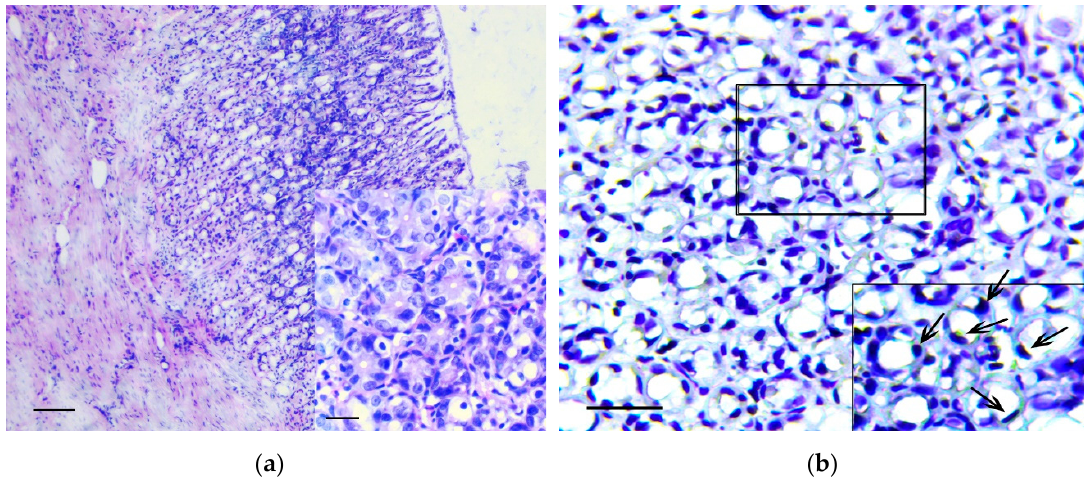
Figure 3. The pathological changes in the pyloric stomach. ( a ) The dysplastic changes in the pyloric glands of stomach. H&E staining, scale bar 100 µ m. In the box the polymorphic prismatic cells with large nuclei, having irregular hyperchromatism and irregular nucleoli in generative zone of pyloric glands are shown. H&E staining, scale bar 100 µ m. ( b ) Positive reaction to Snail in cells lined the pyloric glands resembling signet ring cells. In the box the selected area with signet ring cells (arrows) is shown. Immunoperoxidase staining with antibody to Snail, scale bar 100 µ m.